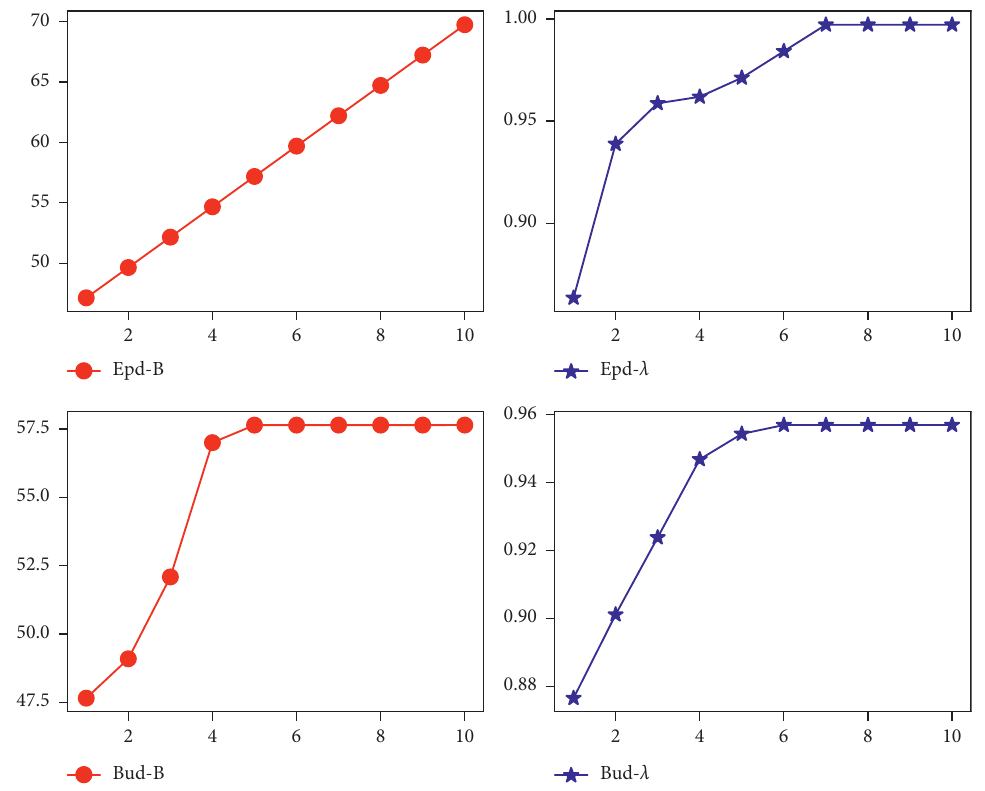
Figure 2: Fluctuation of cost B and utility λ under different uncertain parameters in case 2.